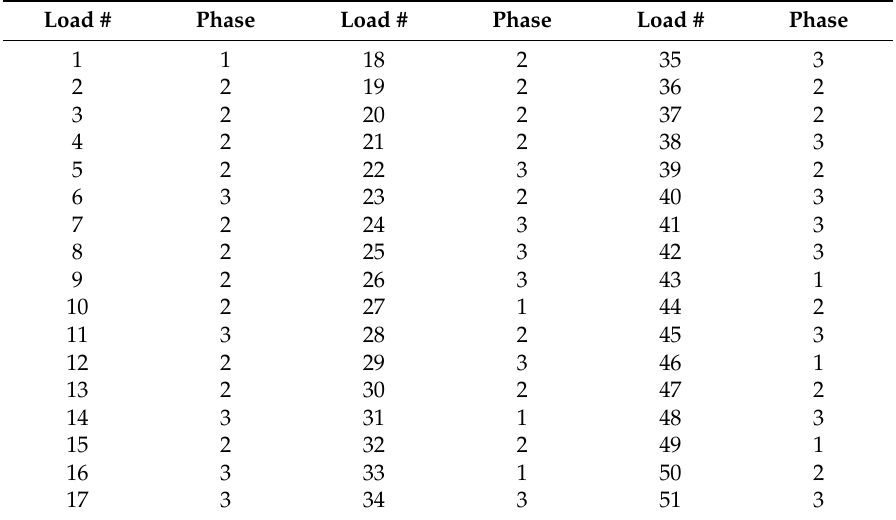
Table 5. Connections for the Bariloche feeder, using the proposed method.